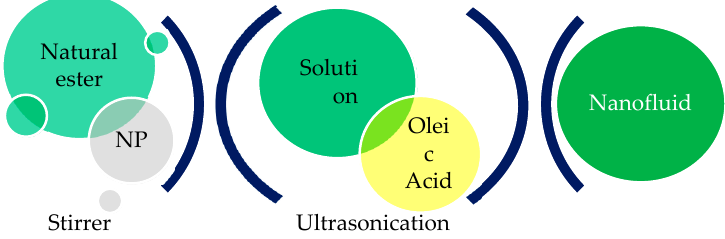
Figure 1. Diagram of two-step method for preparation of nanofluids (NFs).